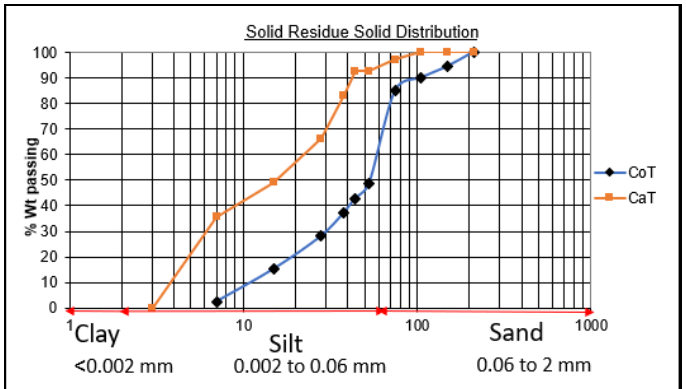
Figure 5. Size distribution (Krumbein phi scale) of solid tailings.